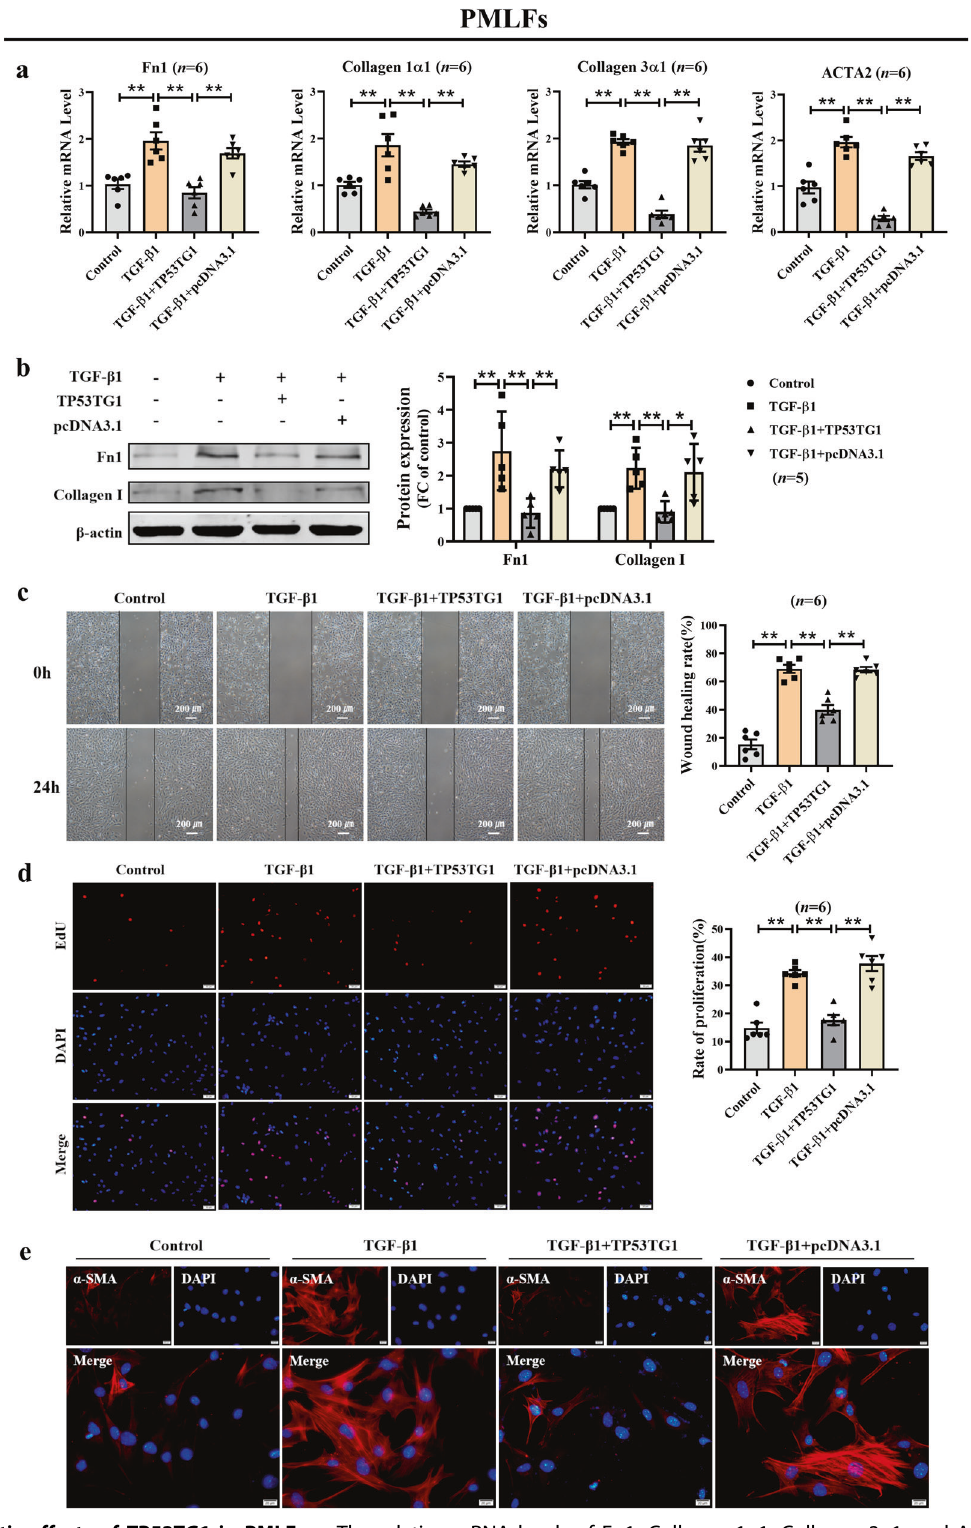
Fig. 5 Anti- fi brotic effects of TP53TG1 in PMLFs. a The relative mRNA levels of Fn1, Collagen 1 α 1, Collagen 3 α 1, and ACTA2 in TP53TG1 transfected cells after TGF- β 1 induction. b TP53TG1 inhibited the protein expression of fi brotic markers caused by TGF- β 1 in PMLFs. c The migratory of PMLFs was attenuated by TP53TG1, as detected by the wound healing assay. (bar = 200 μ m). d The fl uorescence results of the EdU assay showed the cell proliferation of PMLFs. (bar = 50 μ m). e Immuno fl uorescence staining indicated that TGF- β 1-induced α -SMA positive cells, which were impeded by the enhanced expression of TP53TG1 in PMLFs. (bar = 20 μ m; n = 5). * P < 0.05, ** P < 0.01. PMLFs, primary mouse lung fi broblasts; FC fold change.